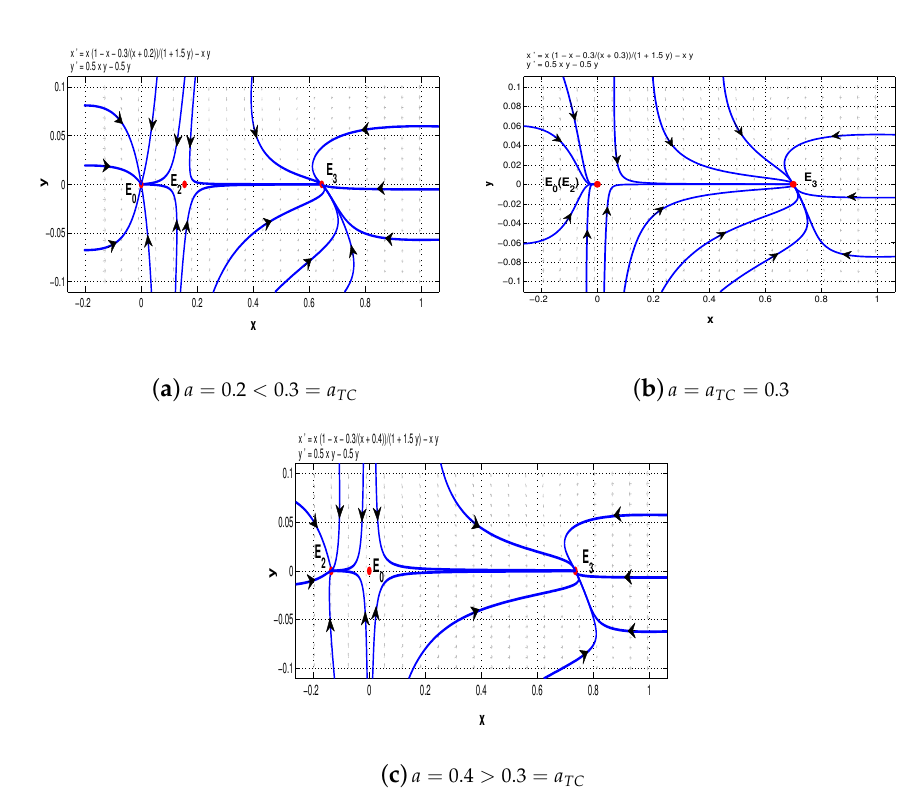
Figure 2. ( a ) Two distinct boundary equilibria and one trivial equilibrium when a < a TC : two stable nodes E 2 and E 3 , and a saddle E 0 . ( b ) A boundary equilibrium and a trivial equilibrium when a = a TC : E 3 is a stable node and E 0 is a saddle-node. ( c ) Two boundary equilibria and a trivial equilibrium when a > a TC : E 2 is a saddle, both E 3 and E 0 are stable